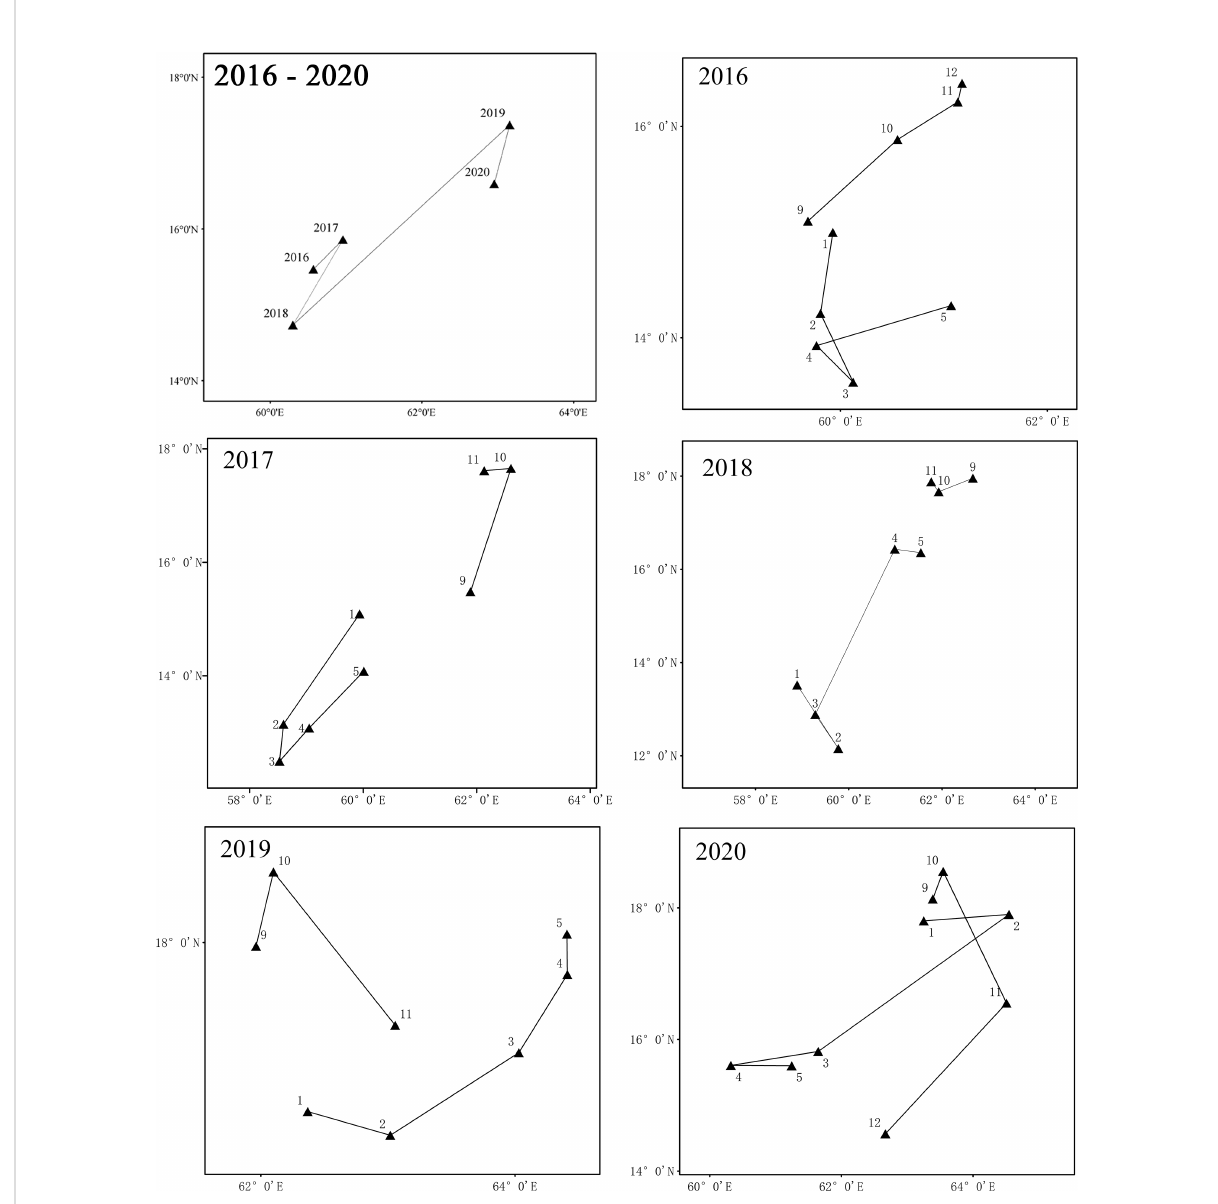
FIGURE 8 Variation of the center of gravity of the Northwest Indian Ocean light falling gear fi shing grounds on a yearly and monthly time